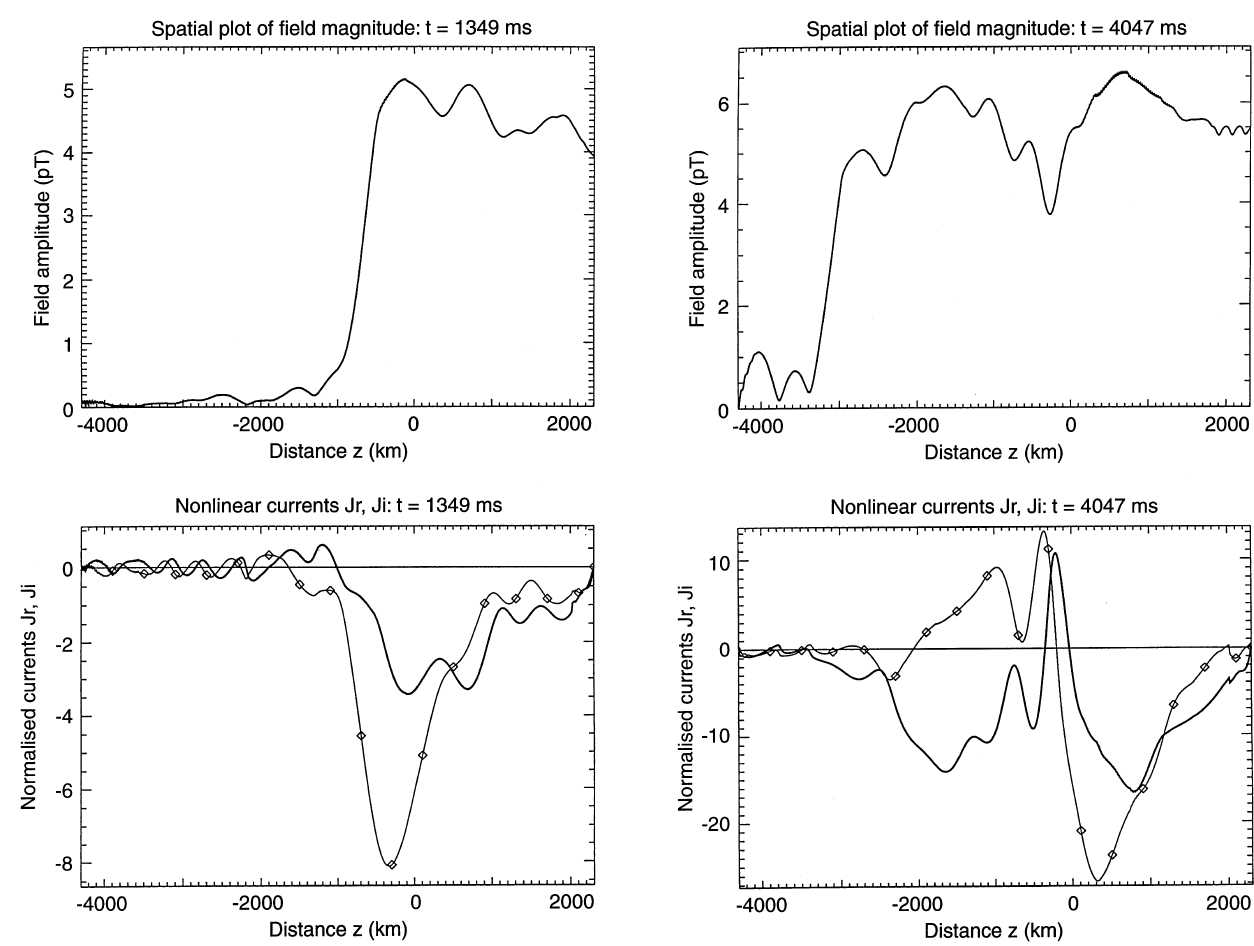
Fig. 15. Case C. Snapshot of riser type GR at t = 1349 ms Fig. 16. Case C. Snapshot of faller type GR at t = 4047 ms